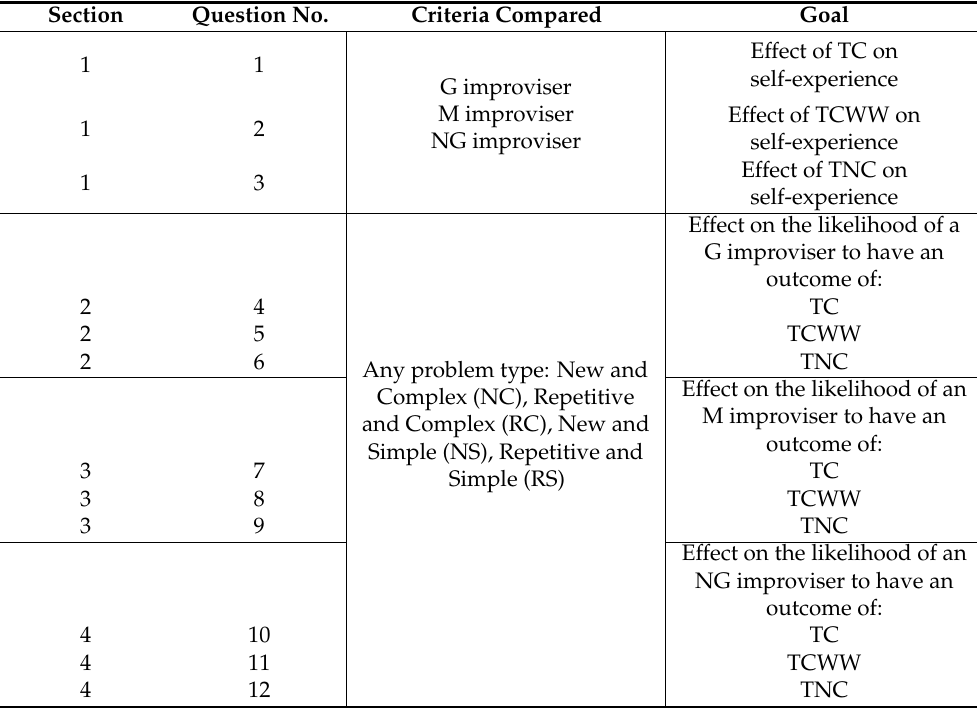
Table 5. Criteria and goal for each survey question.